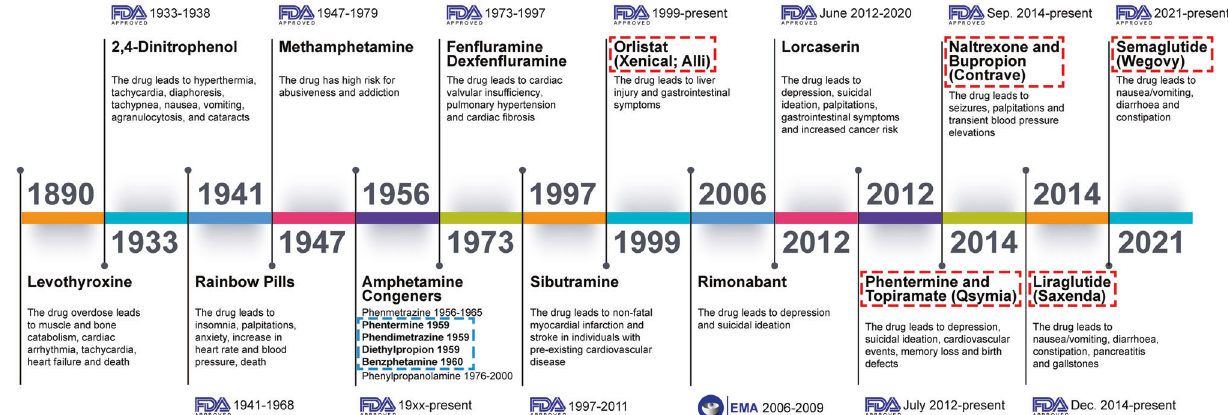
Fig. 7 Timeline of anti-obesity medications approved by the FDA or EMA from the late nineteenth century until today (the red dashed line indicates long-term use while the blue dashed line indicates short-term